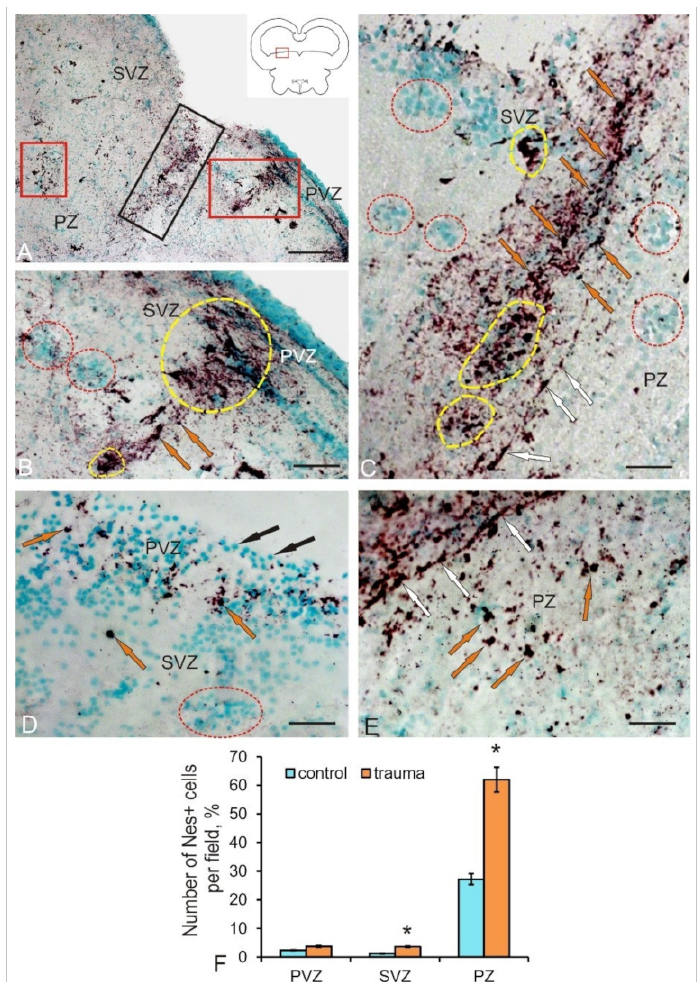
Figure 4. Localization of nestin in the mesencephalic tegmentum of juvenile chum salmon, Oncorhynchus keta on day 3 post-injury. ( A ) A general view of the injury zone: black rectangle outlines the central cluster Nes + NPCs in the injury area; additional Nes + NPCs clusters are outlined by red rectangles. ( B ) An enlarged fragment of additional Nes + foci (outlined by yellow dotted lines): reactive neurogenic niches (outlined by red dotted lines) and Nes + cells (orange arrows). ( C ) An enlarged injury area containing clusters of Nes + cells (orange arrows) and their clusters inside the traumatic focus Nes + NPCs located along the Nes– guiding fibers of radial glia (white arrows). ( D ) Nes + cells of type 4 (orange arrows); reactive groups of negative cells containing Nes + granules in PVZ and SVZ (orange arrows) and Nes– cells (black arrows) in the near-injury zone. ( E ) Near-injury parenchymal zone containing Nes + NPCs and Nes– fibers of radial glia (white arrows). IHC nestin labeling in combination with methyl green staining. ( F ) The quantitative ratio of Nes + cells in the control and after traumatic injury. ( n = 5 in each group; * p ≤ 0.05, significant di ff erence vs. control groups); Student–Newman–Keuls test. Scale bar: (A) = 200 µ m; (B–E) = 100 µ